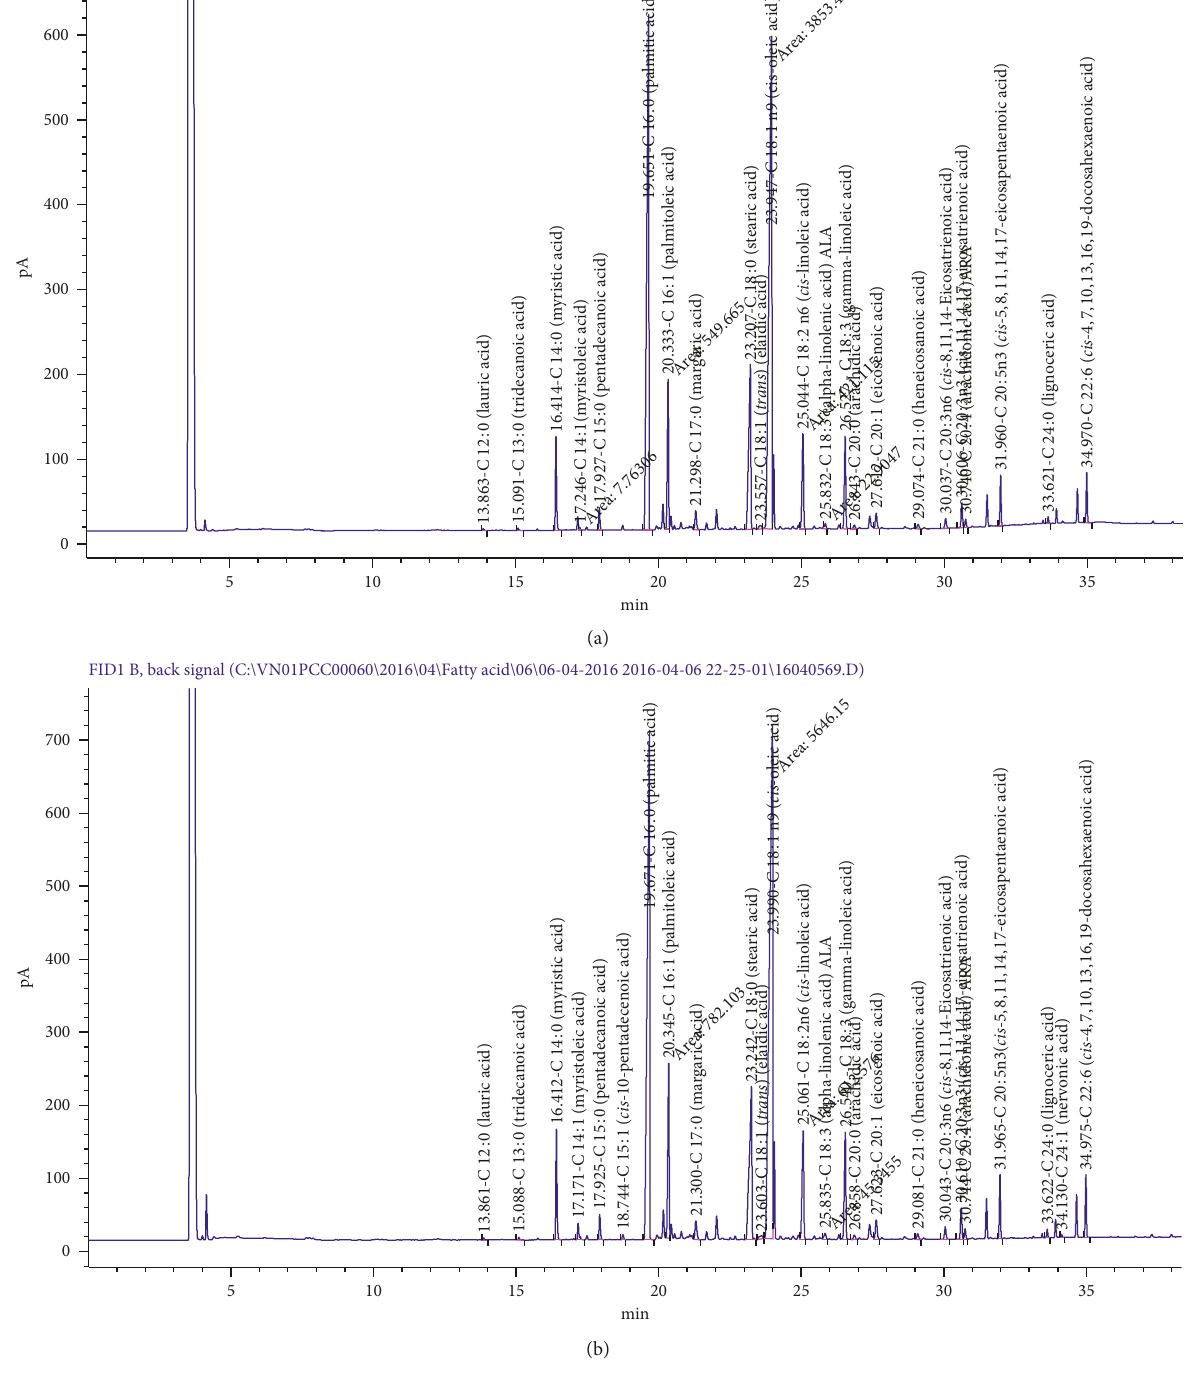
Figure 5: Chromatogram of GC/FID analysis of the fatty acids in methyl ester (a) and in methyl ester-DES